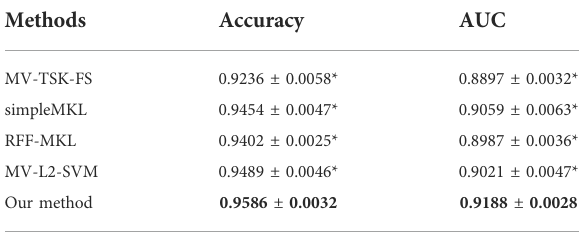
TABLE 3 Comparison with state-of-art multimodality methods in terms of accuracy and AUC. Methods